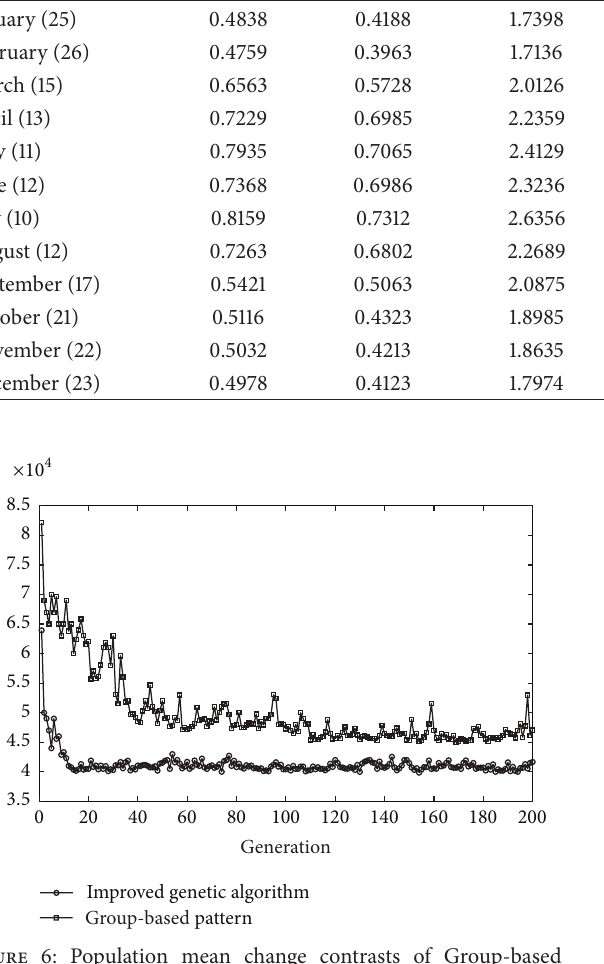
Figure 7: Population mean change contrasts of CW